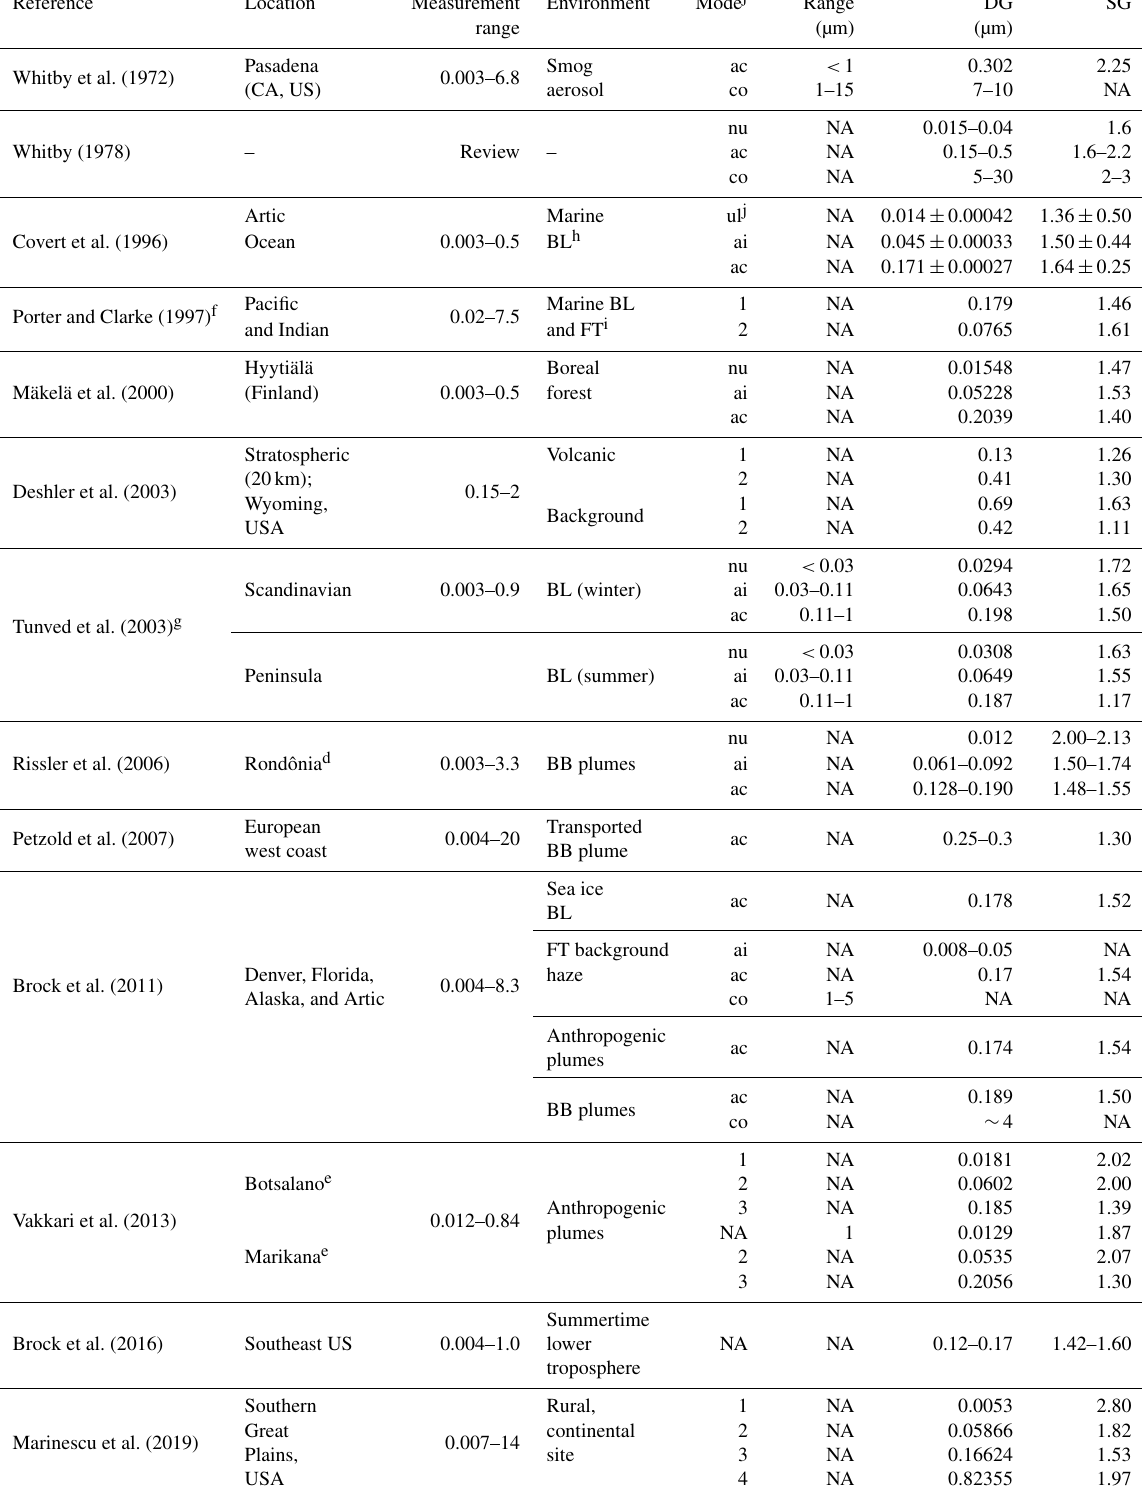
Table 3. Summary of published observed lognormal size distribution parameters. ND = No